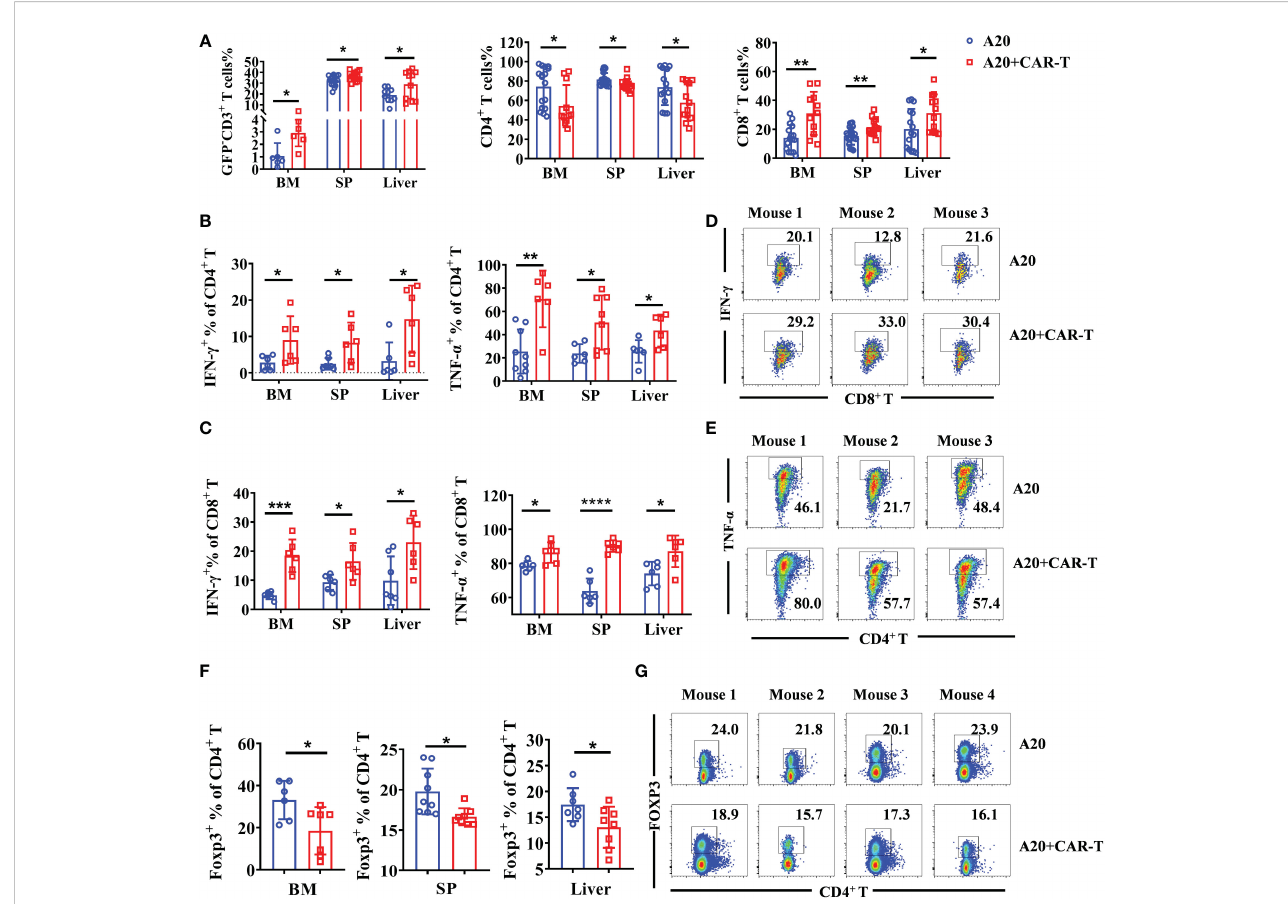
FIGURE 4 Intrinsic T cells were aroused in the remissive stage after anti-CD19 CAR T-cell treatment. (A) Percentage of CD3 + T cells and the subsets. (B, C) The cytokine expression on CD4 + and CD8 + T cells. (D, E) The representative fl ow data of IFN- g and TNF- a produced CD8 + and CD4 + T cells from three mice. (F) The percentage of Treg cells in the BM, spleen, and liver were analyzed, and statistical analysis was done. (G) The representative data from SP on day 15 were shown. Cells were gated on CD4 and the expression of Foxp3 was shown. There were two or four repeated experiments. Data were mean ± SD and compared using unpaired Student ’ s t- test. * P < 0.05, ** P < 0.01, *** P < 0.001, **** P <